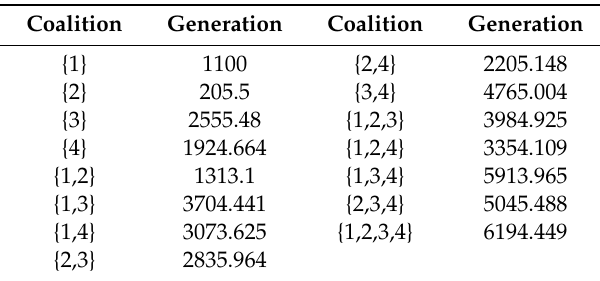
Table 1. Generation of all possible non-empty coalitions (MWh).